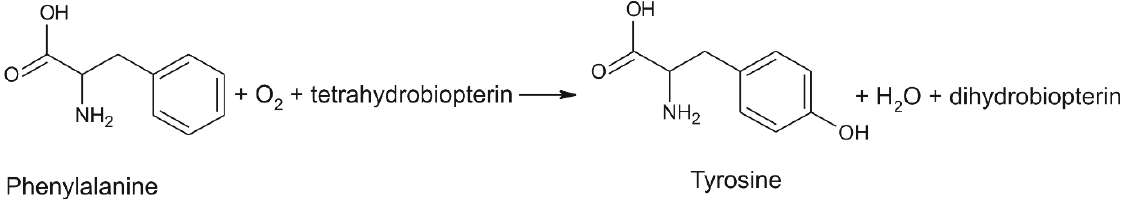
Figure 1. Conversion of Phe in Tyr (adapted from [16]).